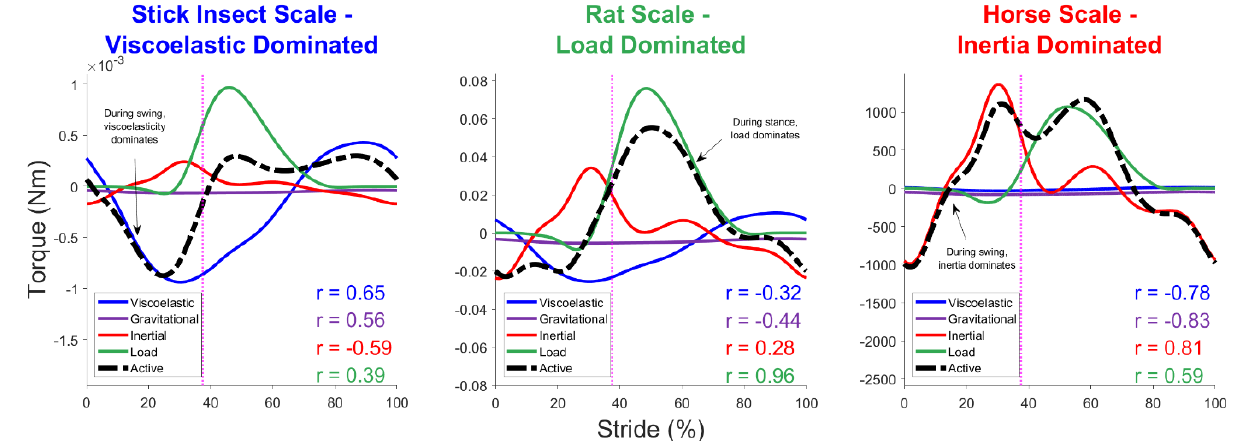
Figure 5. Torque contributions are shown for the modeled hip joint at the scale of a stick insect, rat, and horse. Modeled active muscle torque profiles (black) represent the response of the hindlimb muscles to constituent hindlimb torques. Individual constituent torques are shown for viscoelastic (blue), gravitational (purple), inertial (red), and load (green) forces. As the scale of the model increases, the constituent torque that dominates the active muscle response changes. Linear correlation coefficients, r , represent how the constituent torques correlate with active muscle torque. Biomimetics 2022 , 6 , x FOR PEER REVIEW